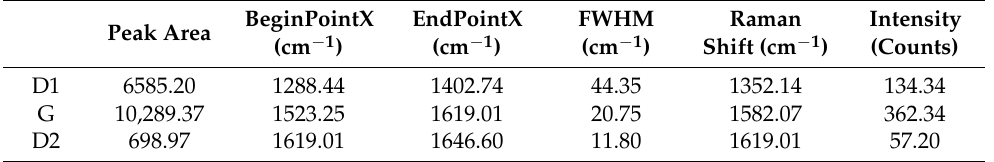
Table 4. Peak position parameters in the Raman spectrum of graphite in the sample